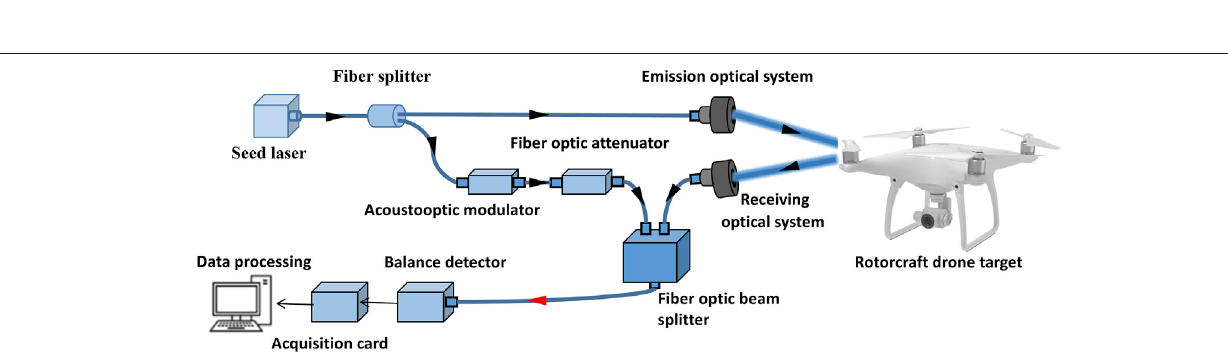
FIGURE 4 | (A) Flow chart of the rotor aspect ratio estimation algorithm based on the time-shift method. (B) Relationship between the estimated aspect ratio and actual aspect ratio. (C) Estimation error of the aspect ratio.